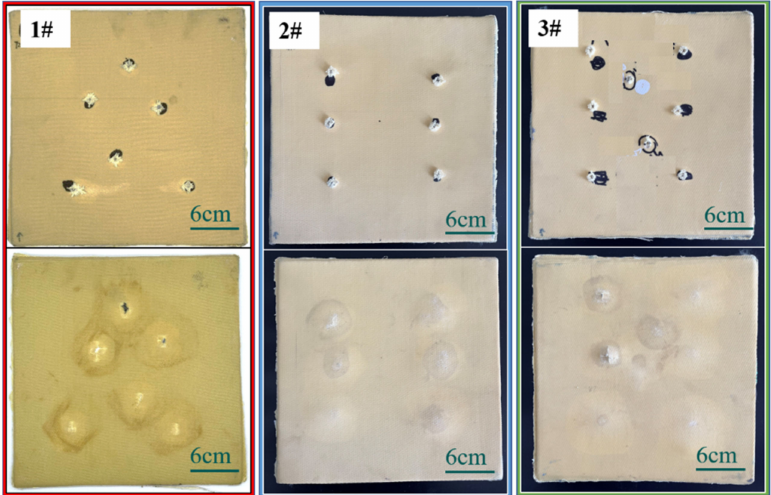
Figure 15. Destruction morphologies of the front and back surfaces of the target plate prepared by fabrics with different weft